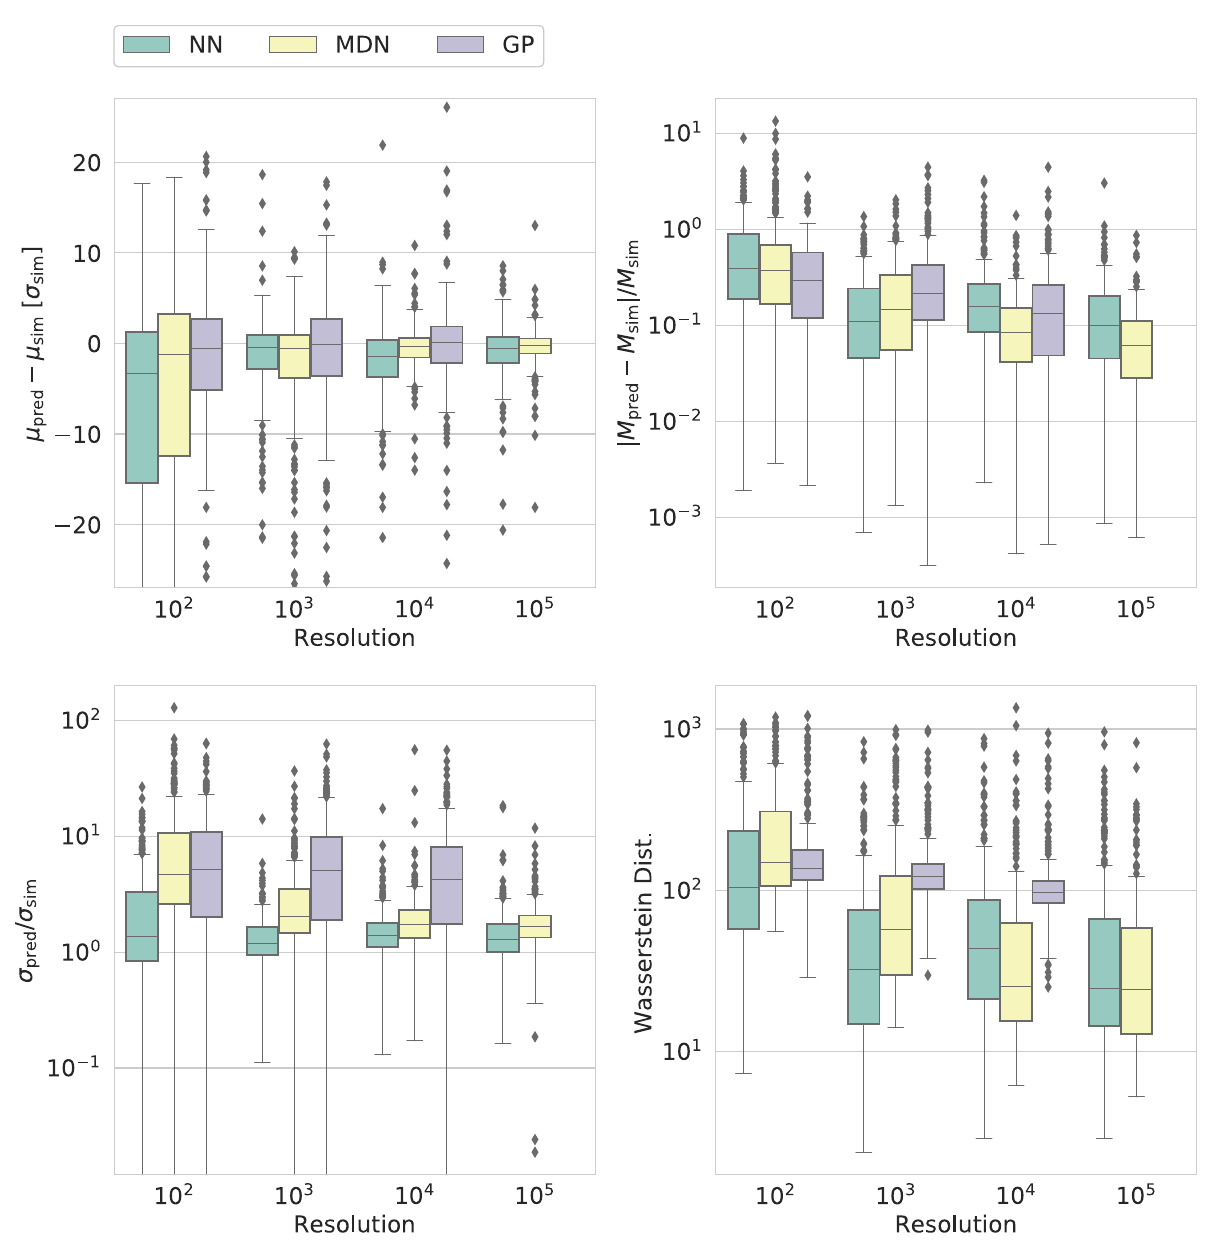
Fig 3. Counterpart to Fig 2 for our epidemiological SIRDS model. The plot shows different metrics of the performance of emulators for one of the output variables of the SIRDS model, the total duration of the epidemic. For the other outputs, we refer the reader to S8